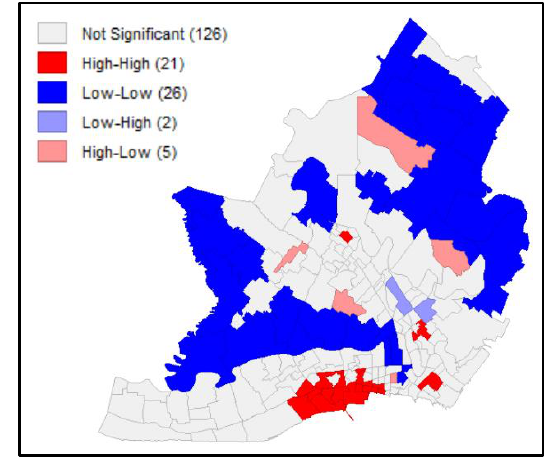
Figure 3. 2015 population density of each brgy with clustering, Moran’s I = 0.450, p-value = 0.001 (significant at p <=